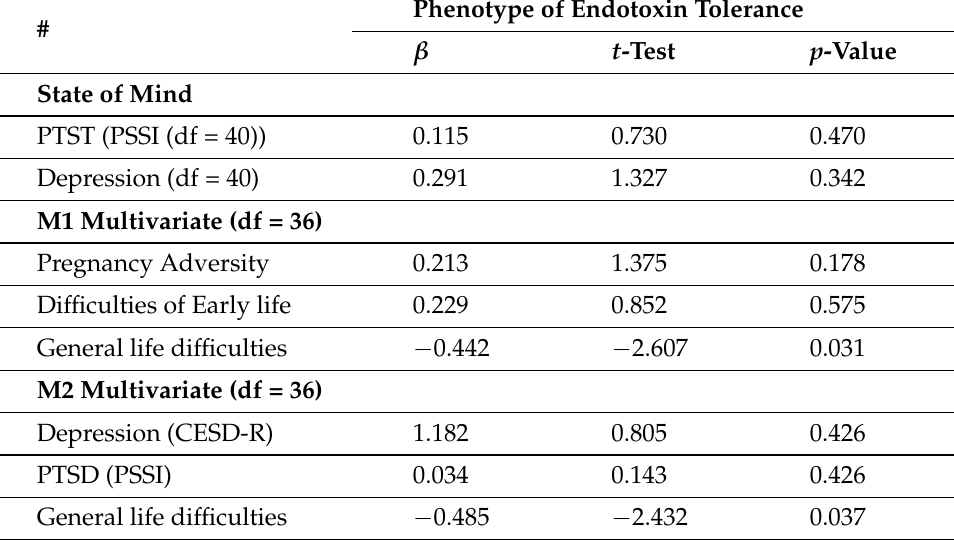
Table 5. Adversity throughout life, adversity during vulnerable times, and mental health both independently and jointly correlate with the endotoxin tolerance phenotype.